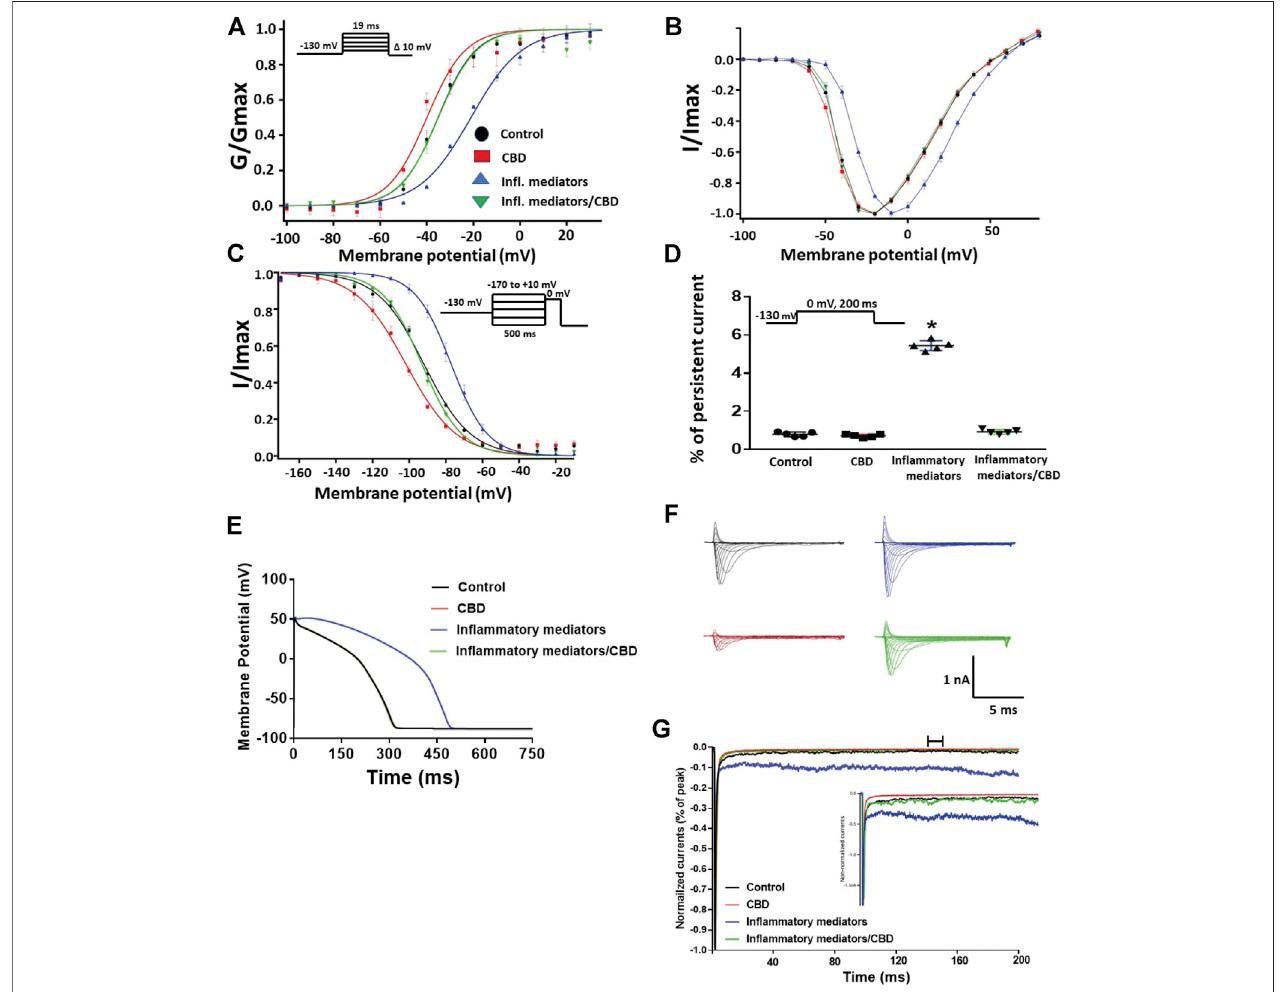
FIGURE 5 | (A) Effect of CBD (5 μ M, perfusion) or its vehicle on the conductance curve measured from human iCell cardiomyocytes (hIPSC-CMs) incubated with in fl ammatory mediators (24 h) or their vehicle with the insert showing the protocol ( n (cid:2) 5, each). (B) IV curves (C) Effect of CBD (5 μ M, perfusion) or its vehicle on SSFI of human iCell cardiomyocytes (hIPSC-CMs) incubated with in fl ammatory mediators (24 h) or their vehicle with the insert showing the protocol (n (cid:2) 5, each). (D) Effect of CBD (5 μ M, perfusion) or its vehicle on the percentage of persistent sodium currents of human iCell cardiomyocytes (hIPSC-CMs) incubated with in fl ammatory mediators(24 h)ortheirvehiclewiththeinsertshowingtheprotocol( n (cid:2) 5,each). (E) EffectofCBD(5 μ M,perfusion)oritsvehicleonthe Insilico actionpotentialduration of human iCell cardiomyocytes (hIPSC-CMs) incubated in in fl ammatory mediators (24 h) or their vehicle. (F) Representative families of macroscopic currents. (G) Representative persistent currents across conditions. Currents were normalized to peak current amplitude. Bar above current traces indicates period during which persistent current was measured. Inset shows non-normalized currents. * p < 0.05 vs. corresponding “ Control ” values using one-way ANOVA along with post hoc